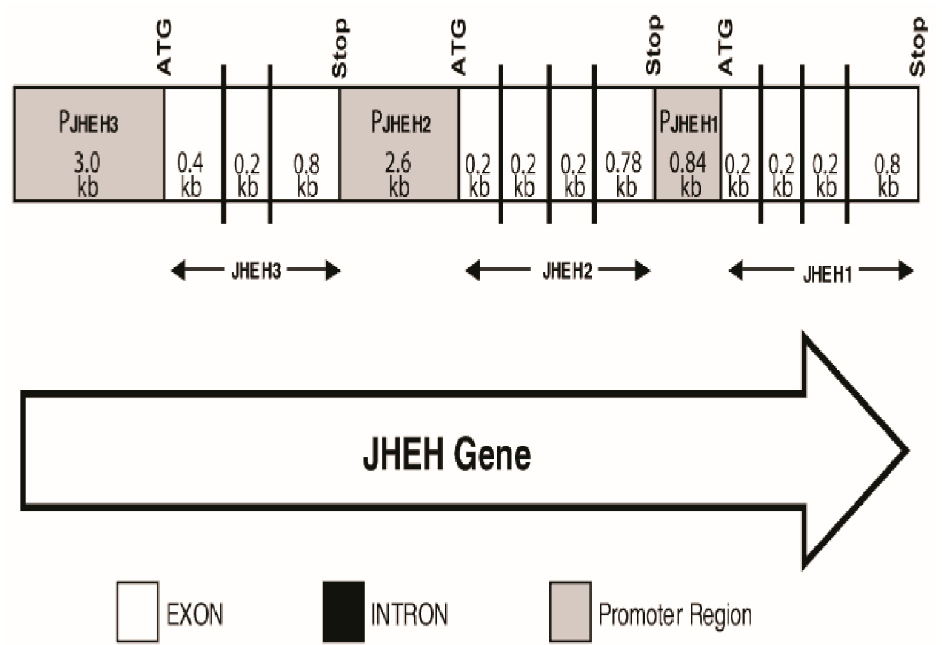
Figure 2. Genomic DNA sequence of jheh including intron (black lines) exons (white colored squares) and promoters (gray colored squares) of jheh 1, jheh 2 and jheh 3. Arrow follows the 5 ′ to 3 ′ direction of D. melanogaster genome.